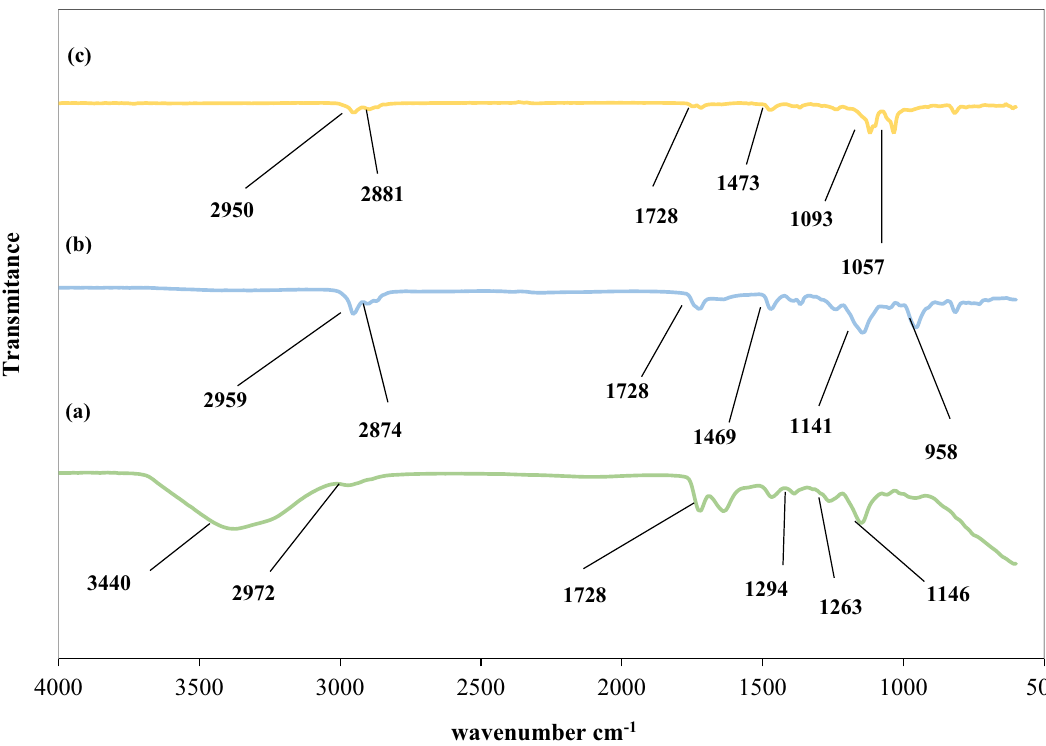
Figure 1. FTIR spectra of the working polymeric resin: ( a ) A XAD-7; ( b ) Amberlite XAD-7 resin impregnated with CYANEX-272; ( c ) AXAD-7 resin impregnated with CYANEX-272 after Ce(III) and La(III) adsorption.